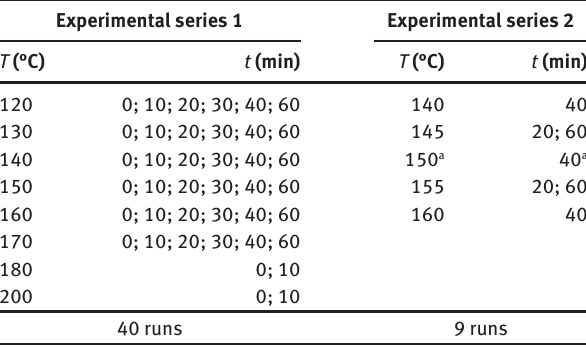
Table 1: Experimental conditions of high methyl ester citrus-apple pectin